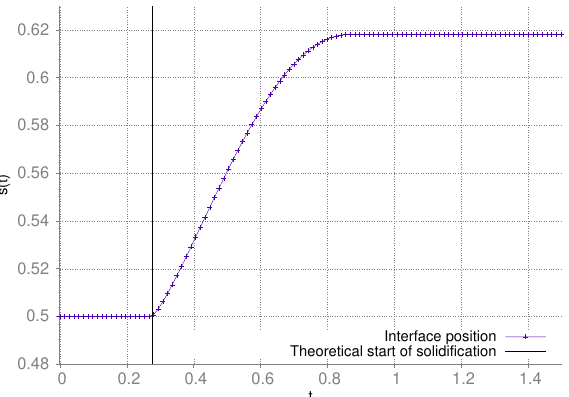
Figure 6. Interface position s ( t ) according to time t — ∆ t is fixed to 10 − 4 .